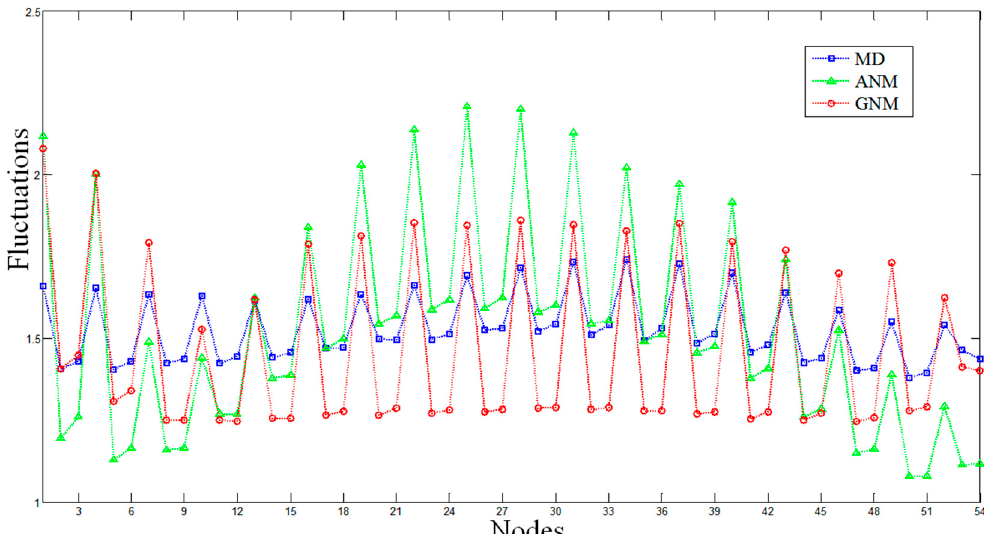
Figure 1. The Root-Mean-Square Fluctuations (RMSF) of the DNA octahedron derived by molecular dynamics (MD, the blue line), Anisotropic Network Model (ANM, the green line), and Gaussian Network Model (GNM, the red line). The RMSFs based on ANM and GNM are calculated when each nucleotide is represented by three nodes. Average fluctuations for only one strand composing the double helices are plotted.